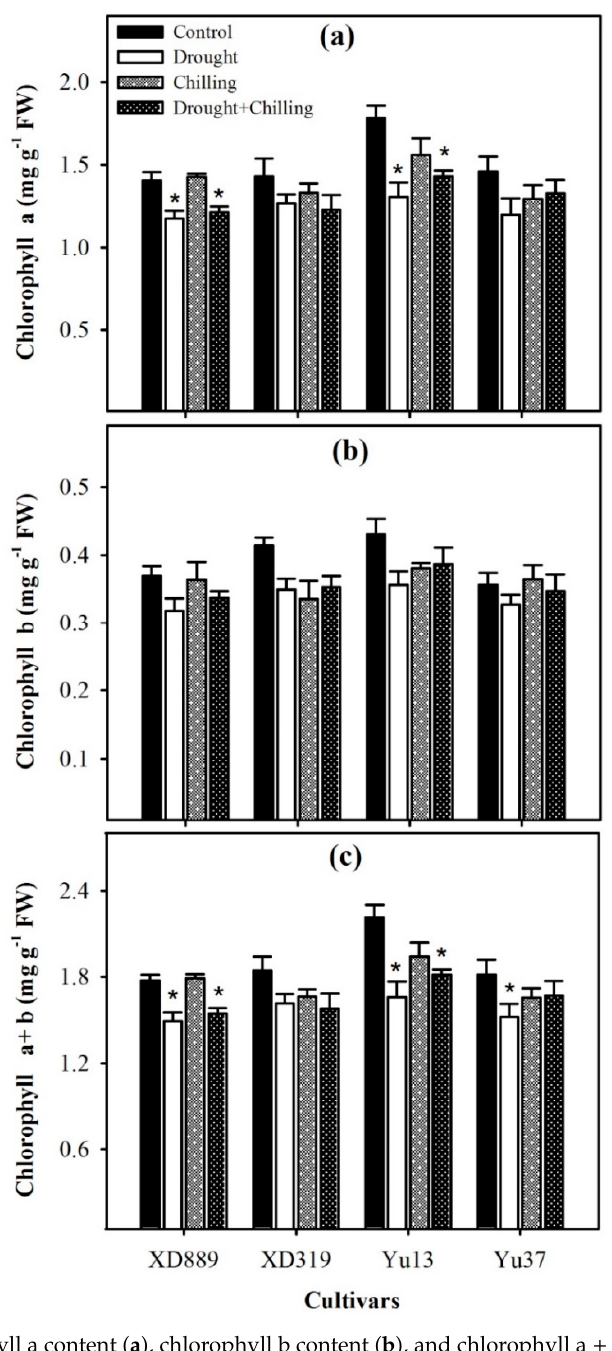
Figure 7. Chlorophyll a content ( a ), chlorophyll b content ( b ), and chlorophyll a + b content ( c ) in four maize cultivars as influenced by the drought, chilling, and drought + chilling stresses. Vertical bars above mean indicate standard error of three replicates. Mean value for each treatment with * indicate significant differences compared with control according to LSD test ( P ≤ 0.05).